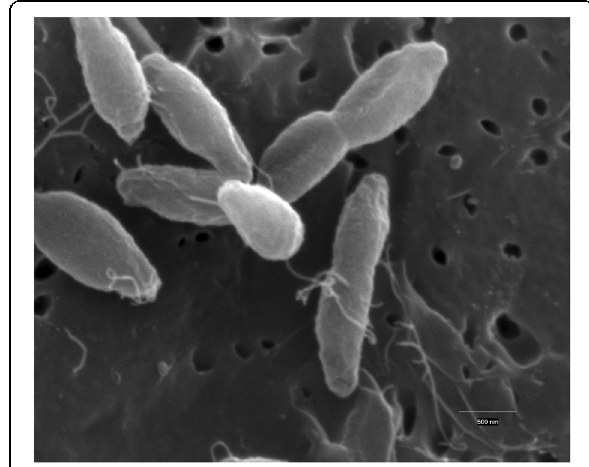
Fig. 2 Scanning electron micrograph of T. sp. strain RQ7 cells after 12 h of growth. Bar, 0.5 μ m